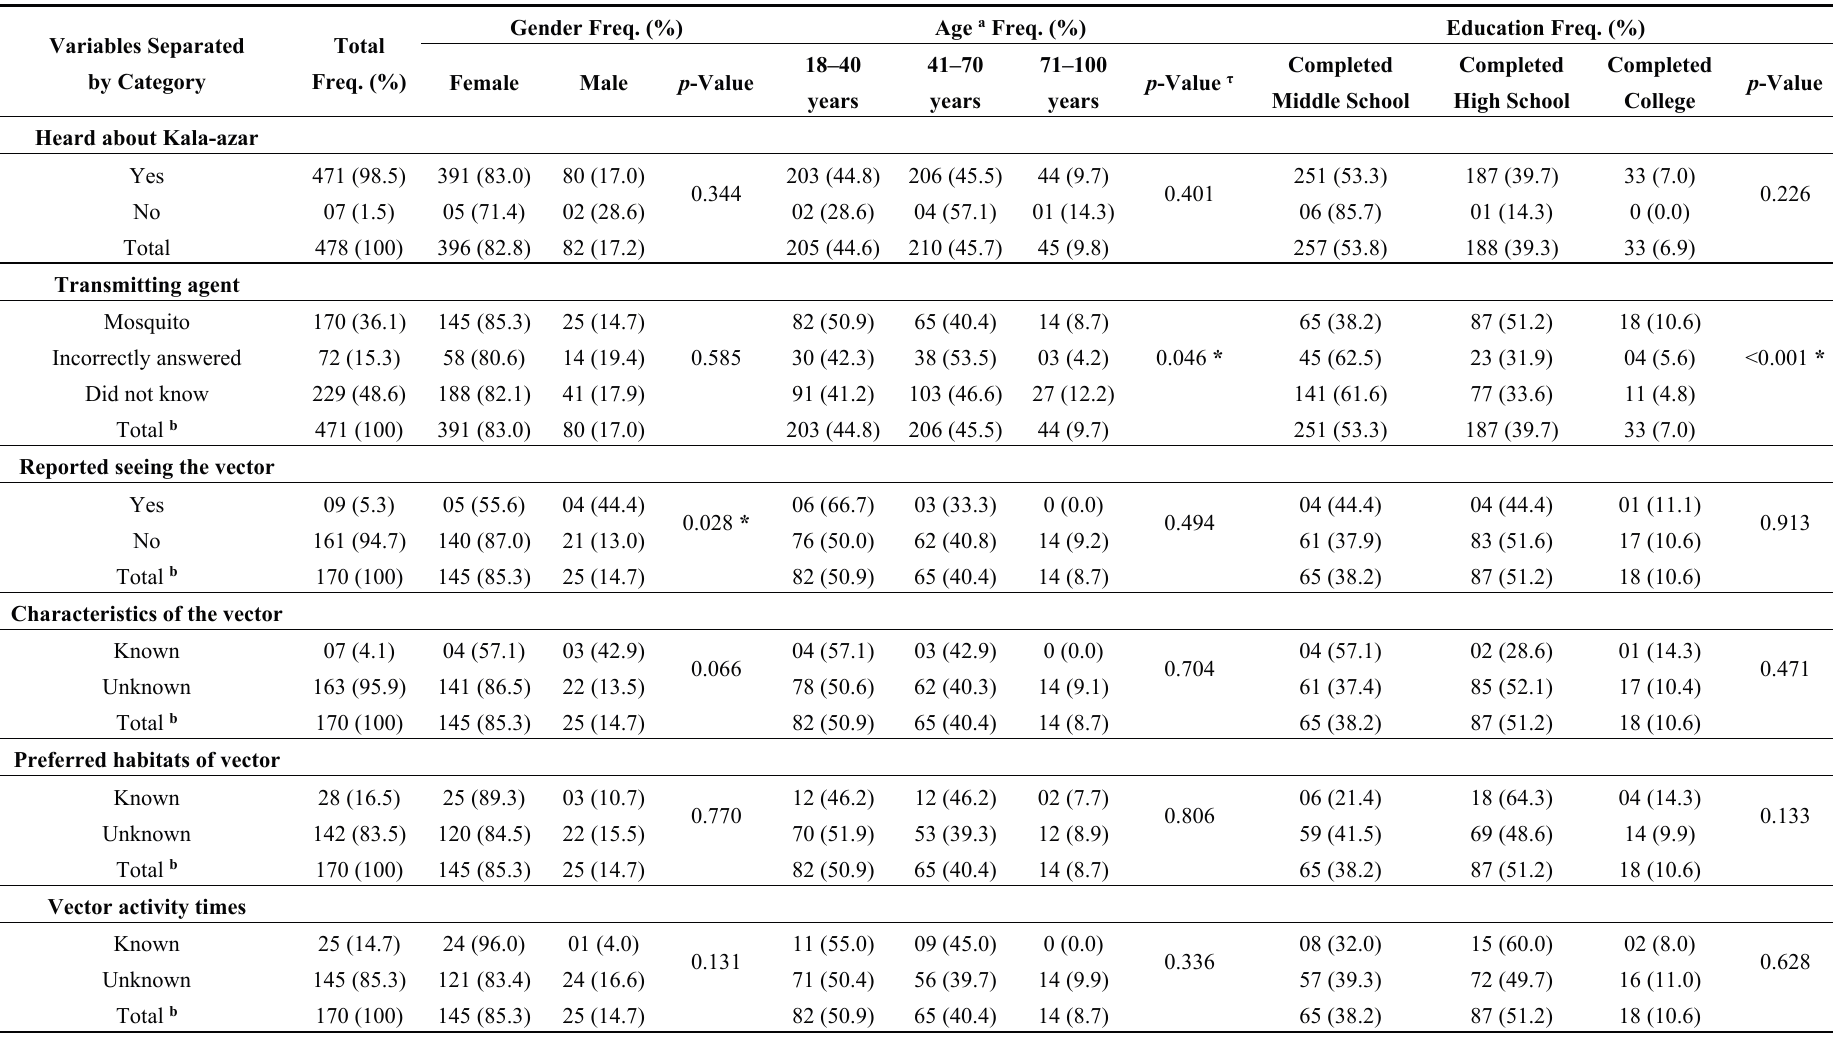
Table 6. Respondents knowledge about the vector of visceral leishmaniasis in Mossoró near the river e associação com perfil social, in the neighborhoods of Ilha de Santa Luzia, Alto da Conceição and Paredões in the city of Mossoró, Rio Grande do Norte areas, 2013. Variables Separated by Category